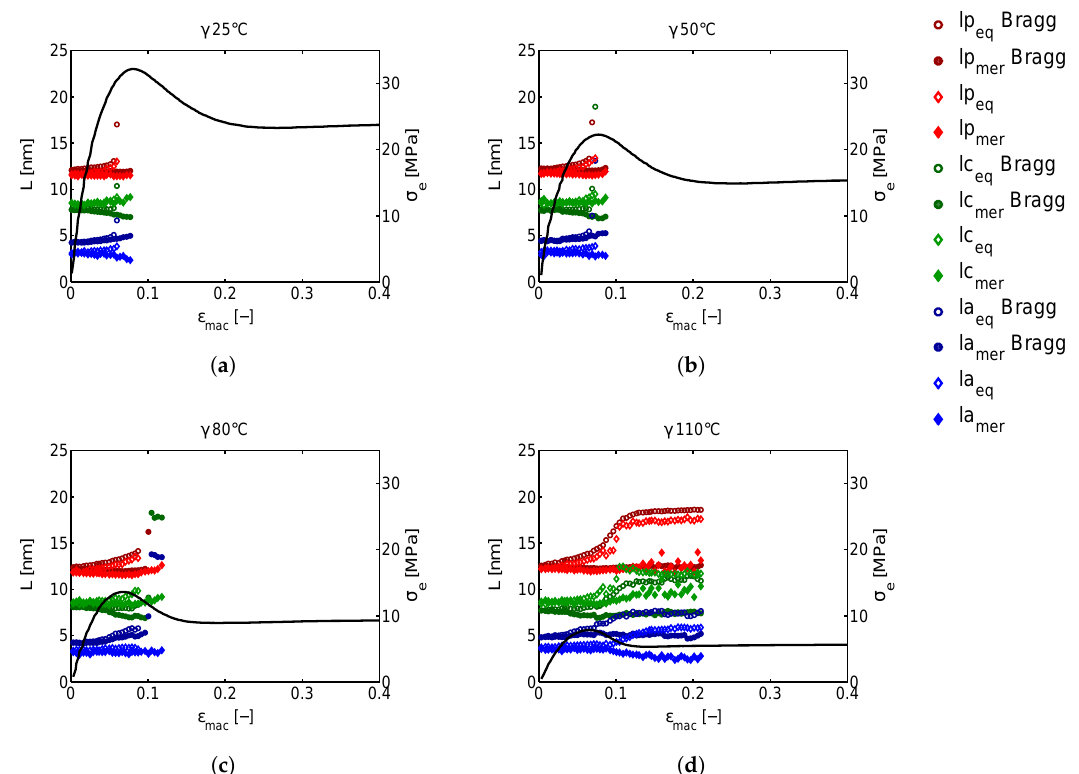
Figure A4. Long period, amorphous layer thickness and lamellar thickness determined via Bragg’s law and the 1D autocorrelation function versus the macroscopic strain for γ -iPP, elongated at 25, 50, 80 and 110 ◦